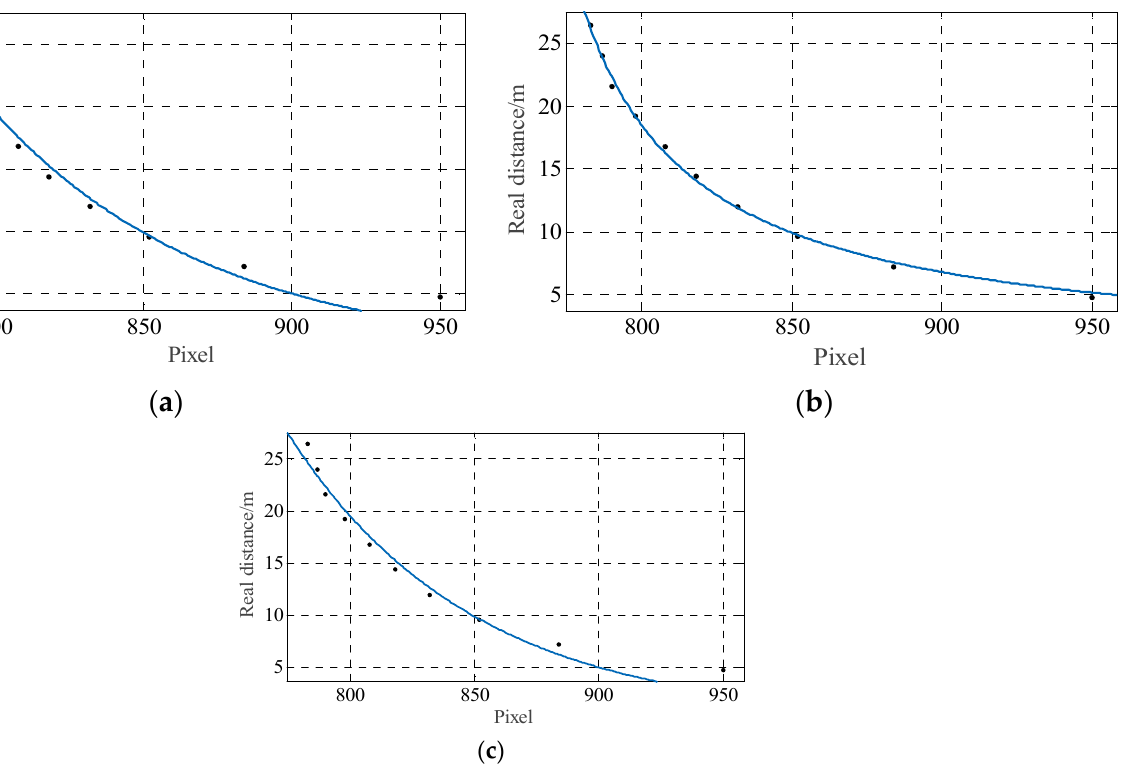
Figure 12. Fitting curves. ( a ) Power function; ( b ) Rational function; ( c ) Exponential function. The performance of the fitted curves was evaluated by three parameters, such as the sum of squared errors (SSE), root mean squared error (RMSE), and coefficient of determination (R-square). The closer the SSE is to 0, the closer the RMSE is to 0, and the closer the R-square is to 1, the better the selected curve fits the data. The three evaluation parameters of the above three fitted curves are shown in Table 2. Table 2. The performance comparison of the three fitting curves.